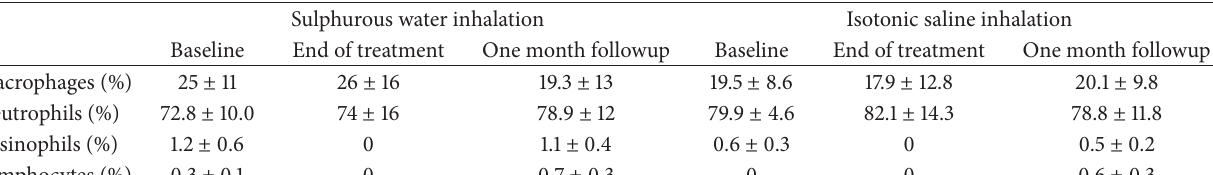
Table 3: Inflammatory cell counts in the sputum of COPD patients.